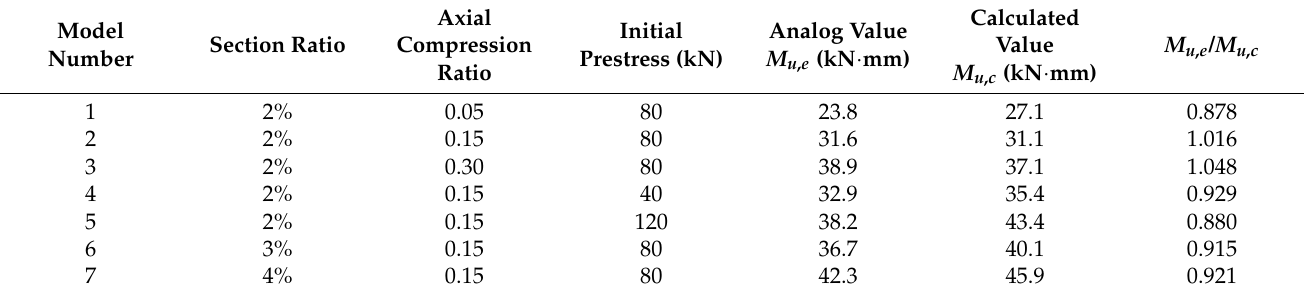
Table 8. Comparison between simulated values and calculated values of flexural bearing